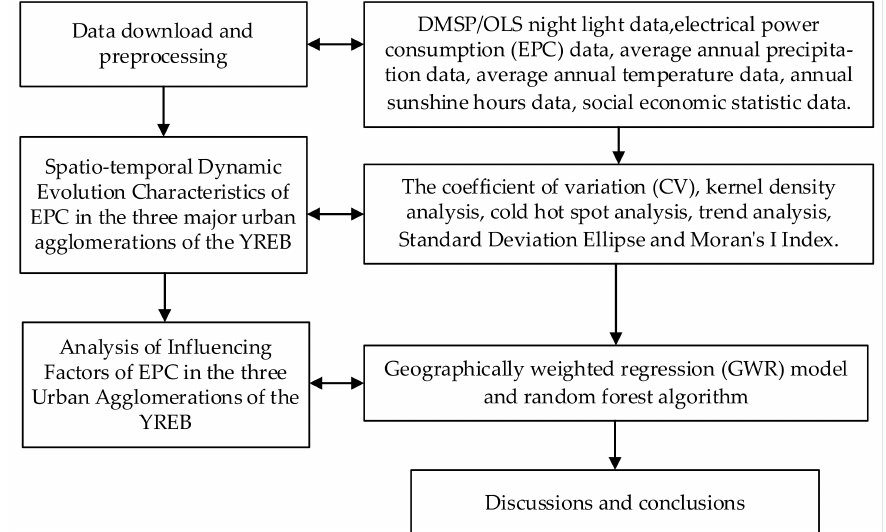
Figure 3. The workflow of this